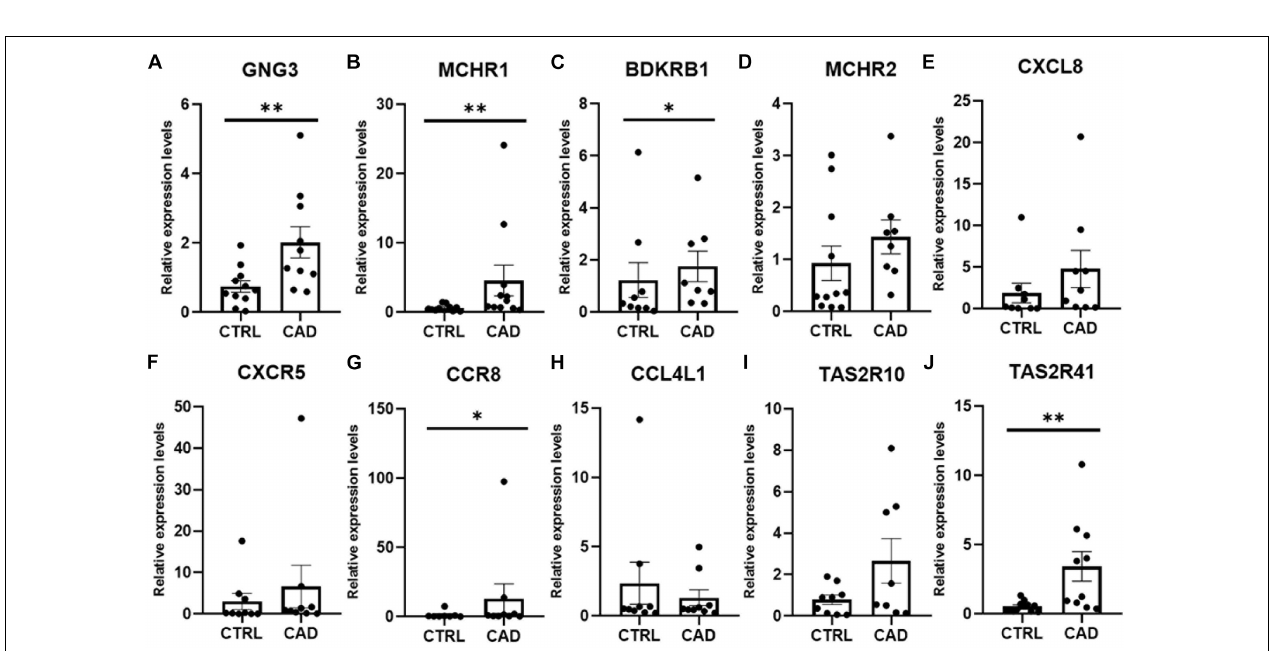
FIGURE 4 | Real-time quantitative PCR (RT-qPCR) verification of 10 hub genes in EAT of CAD. (A) GNG3 expression was significantly increased in the CAD group. (B) MCHR1 expression was significantly higher in the CAD group. (C) BDKRB1 expression was greater in the CAD group. (D) MCHR2 was increased in the CAD group, although the difference was not statistically significant. (E) CXCL8 expression was not statistically different between the two groups. (F) CXCR5 expression was higher in the CAD group, although the difference was not statistically significant. (G) CCR8 expression was significantly higher in the CAD group. (H) CCL4L1 expression was not different in the two groups. (I) TAS2R10 expression was increased in the CAD group, although the difference was not statistically significant. (J) TAS2R41 expression was significantly increased in EAT of CAD. * p < 0.05, ** p < 0.01. In each column, error bars show the mean and standard deviation per